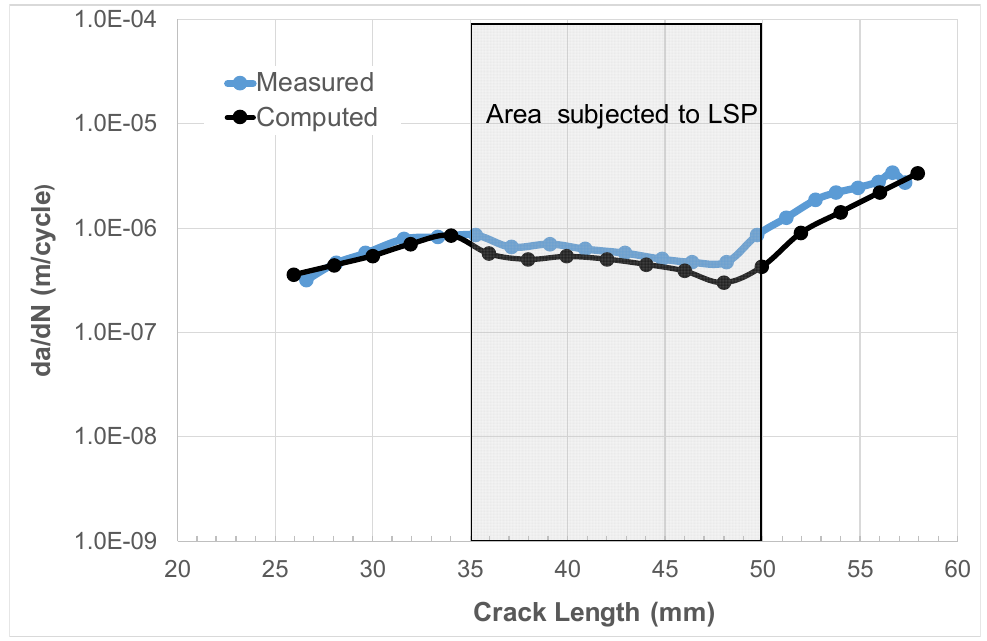
Figure 9. Comparison between the measured [75] and measured da/dN and crack length ( a ) curves.